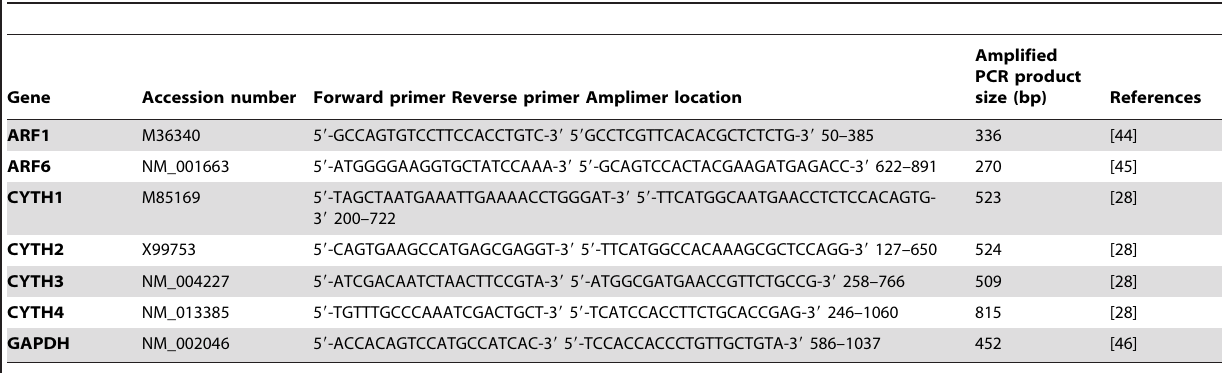
Table 1. The primer sequences used for RT-PCR analysis of ARF6, CYTH3 and GAPDH mRNA expression in the human